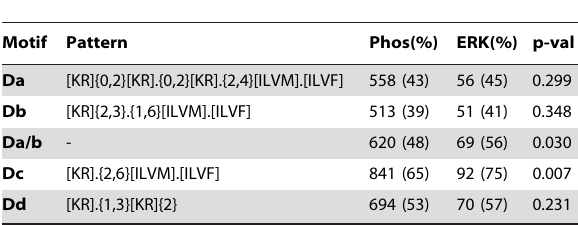
Table 1. MAPK docking pattern hits on human proteins.